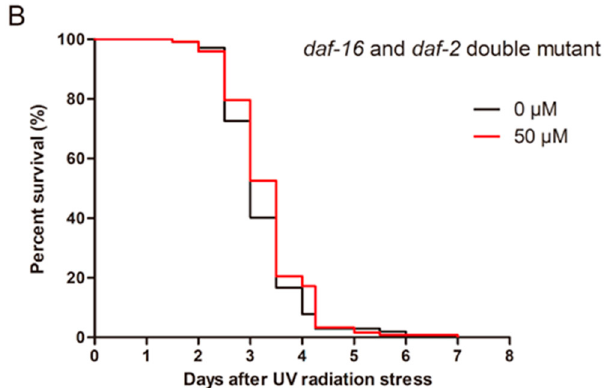
Figure 4. The effects of ellagic acid on the daf-16 mutant worms (CF1308) and daf-2 and daf-16 double-mutant strains (CF1588) exposed to UV radiation stress. ( A ) The daf-16 mutant worms CF1308 in the L4-stage were transferred onto NGM agar plates with 50 µ M ellagic acid or without ellagic acid for two days. Then, the worms were exposed to a dose of 1000 J/cm 2 of UV radiation, n > 100. ( B ) The survival of the daf-2 and daf-16 double-mutant nematodes exposed to UV radiation with 50 µ M ellagic acid or without ellagic acid treatment, n > 100.